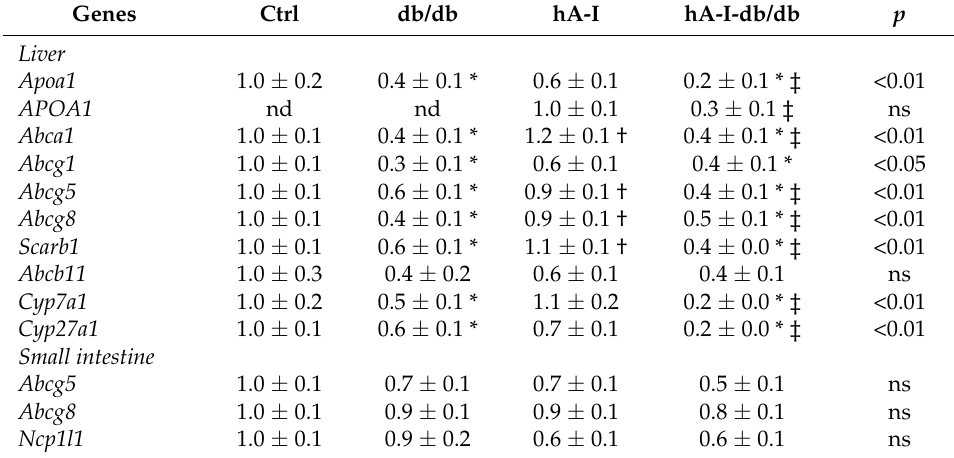
Table 3. Hepatic and intestinal gene expression profiles of molecular targets involved in macrophage-specific reverse cholesterol transport